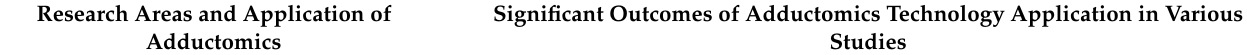
Table 1. Summary of the various applications of adductomics in biomedical research in various research articles published in recent